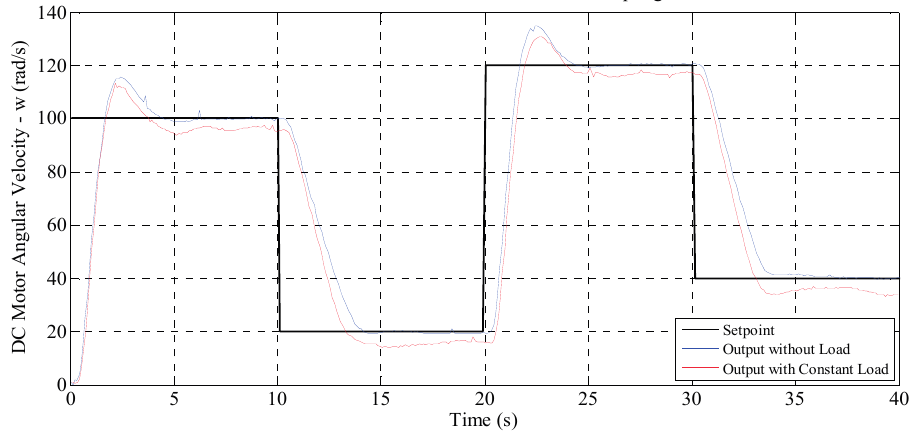
Figure 11. Comparison between the WNCS responses with and without disturbance: wireless sensor with real sampling period of 3 s and soft sensor with multi-rate of 0.1 s. WNCS with Soft Sensor - Wireless Sensor with Sampling Period of 3s